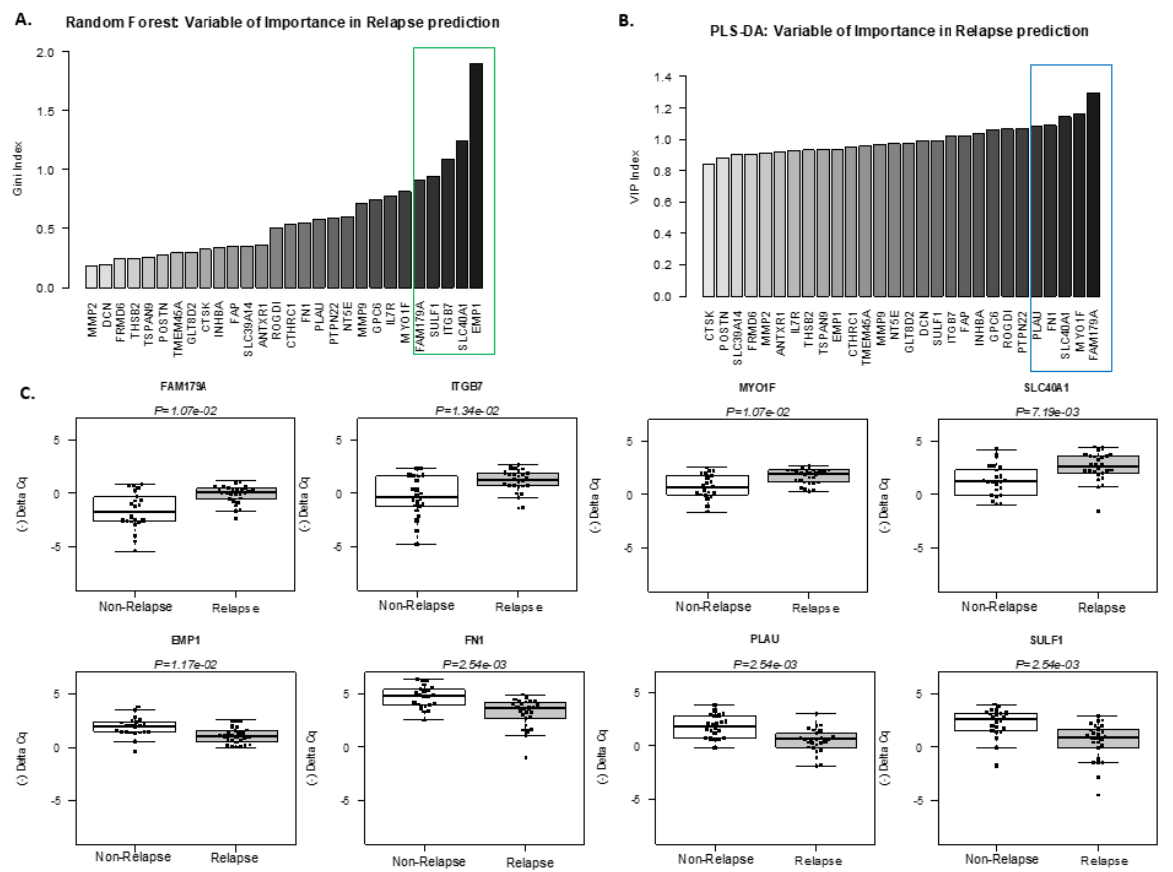
Figure 3. Selection of best predictive genes for outcome stratification by Random Forest and PLS-DA analysis of high- throughput RT-qPCR data. Relative importance of genes that discriminated between “relapsing” and “non-relapsing” groups in high-throughput RT-qPCR data. The bar plots show the mean Gini index of each gene from Random Forest classification ( A ) and variable importance in the projection (VIP) of the PLS-DA method with ( B ) larger values (to the right of the graph) indicating a more important gene within the model. The five top genes are highlighted by a grey box. ( C ) Box plots and strip-charts showing high-throughput qPCR quantification of the 8 selected genes in “relapsing” (grey, n = 26) and “non-relapsing” (white, n = 22) samples. Statistical significance was calculated using the Wilcoxon test followed by a Benjamini and Hoechberg correction. Expressions are given as (−∆Cq).